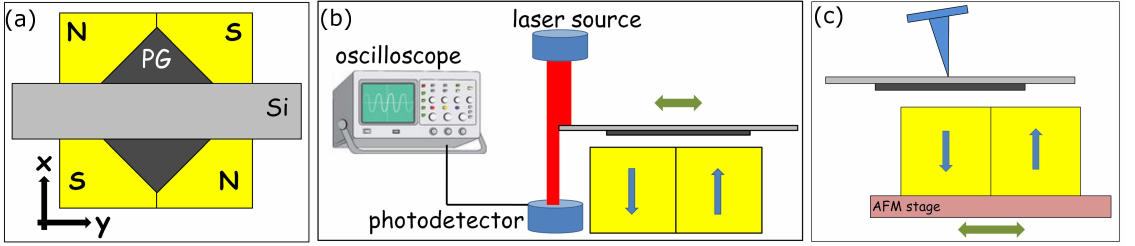
Figure 2. Schematic of D-LFC method: a pyrolytic graphite sheet-Si wafer assembly levitated by a strong magnetic field, drawn from top-view ( a ); laser displacement tracer setup to determine the angular frequency of the levitating system ( b ); diamagnetic levitation spring system mounted on the AFM stage to calibrate the lateral PSPD output ( c ) Blue arrows show the polarity of the magnets, green arrows indicate the direction of the movement of the sample and the AFM stage.